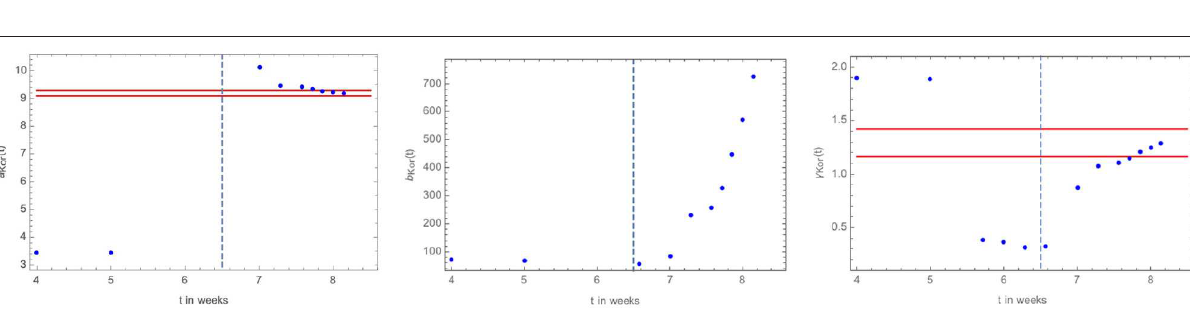
FIGURE 8 | (Left) COVID-19 infected cases in South Korea as function of the week number starting from January 21st 2019. In red, we report the exponential of the epidemic strength model result. (Right) Epidemic strength (the logarithm of the number of infected cases) and the best fit result.